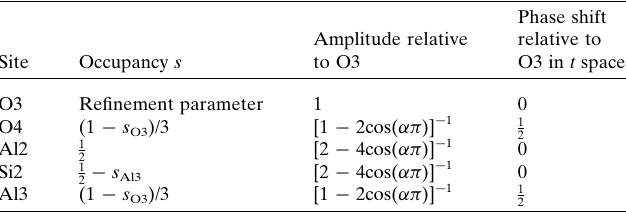
Table 3 Constraints scheme applied during the refinements.